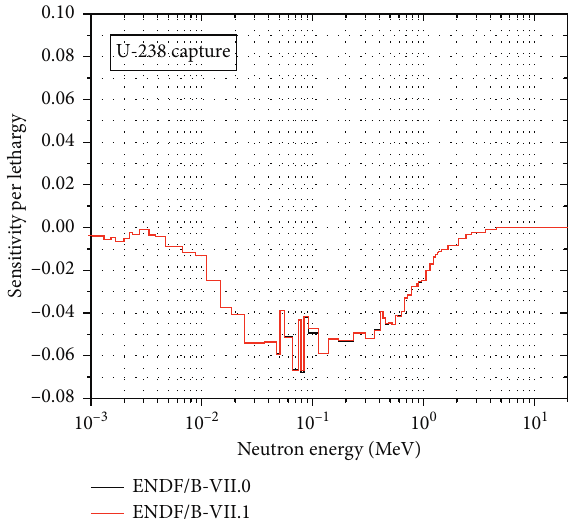
Figure 16: Energy-dependent sensitivities of k cross section.